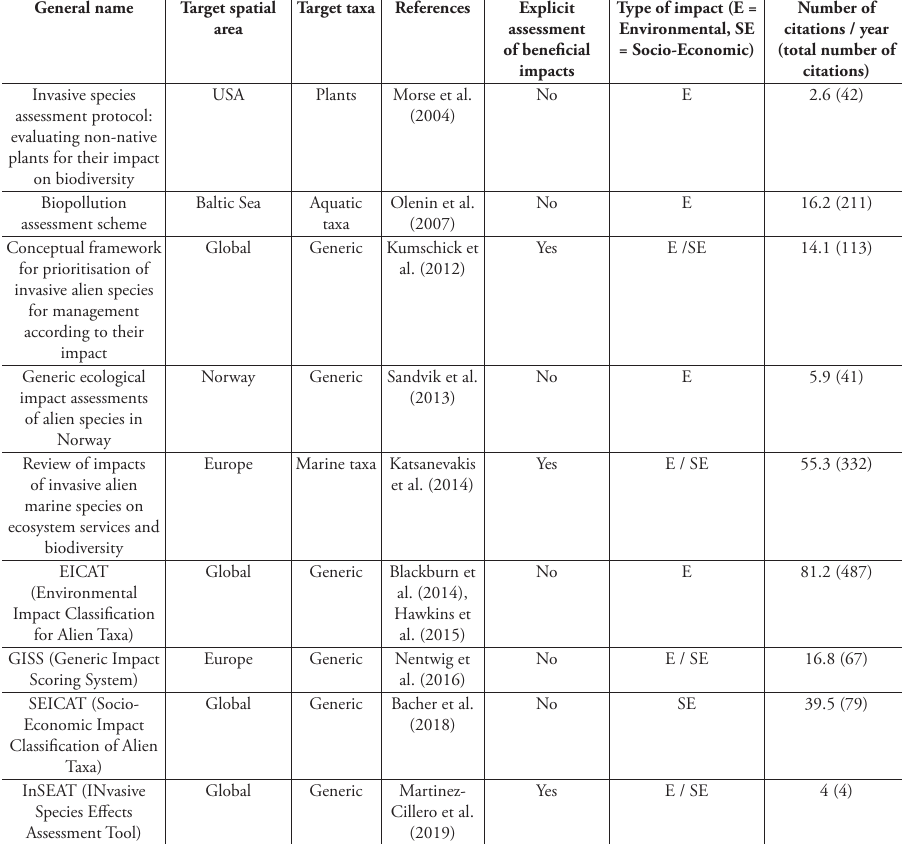
Table 1. List of impact assessment frameworks which assess environmental and/or socio-economic im- pacts developed in the last 30 years. The list has been compiled following Roy et al. 2007, Bartz